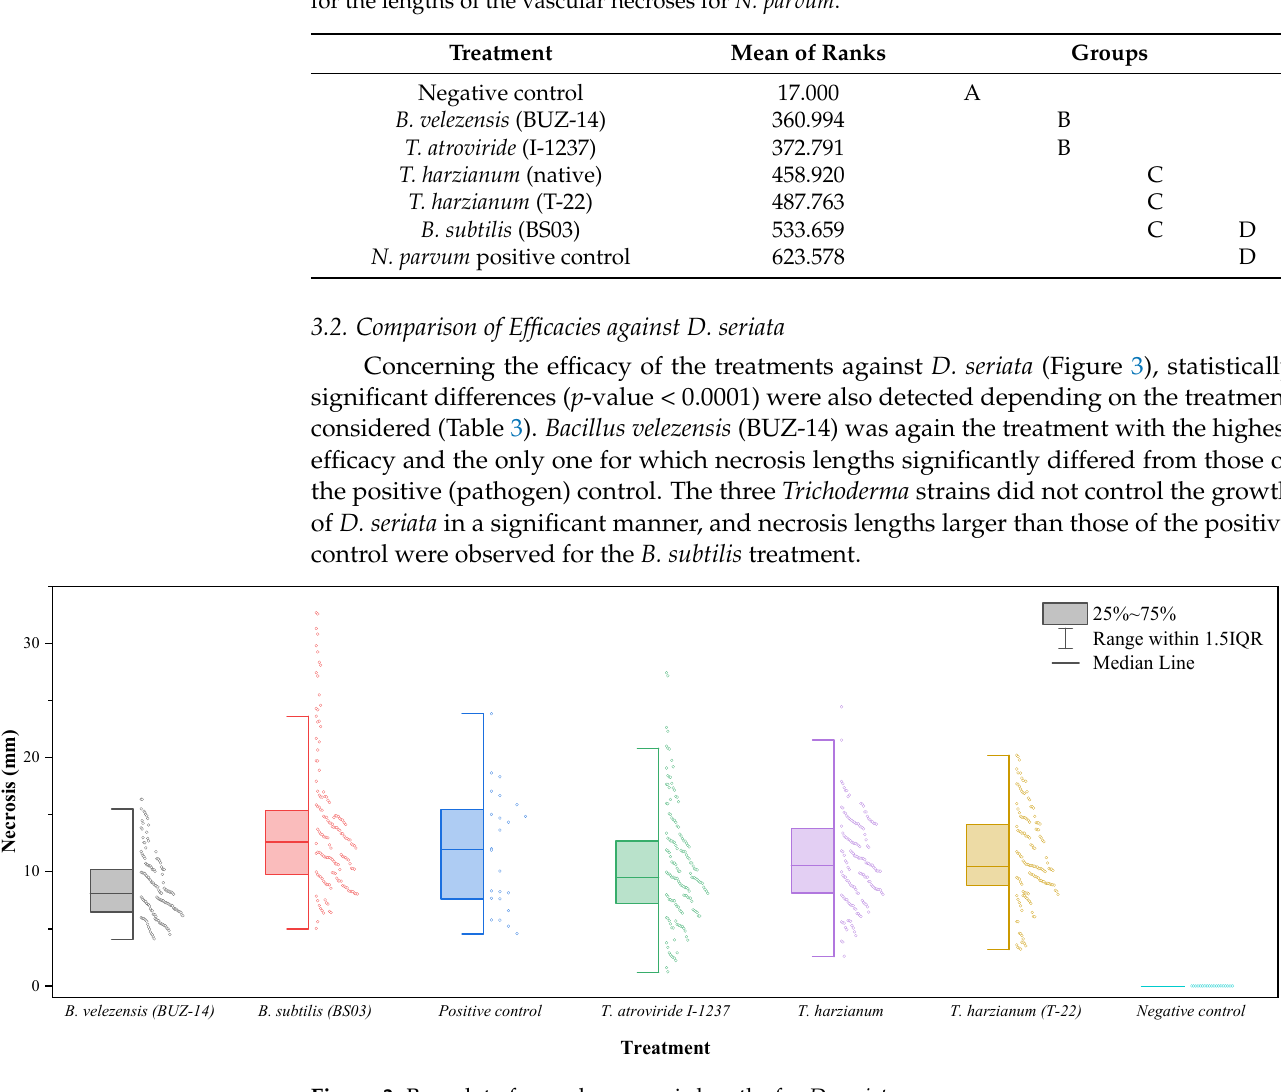
Figure 3. Box-plot of vascular necrosis lengths for D. seriata .